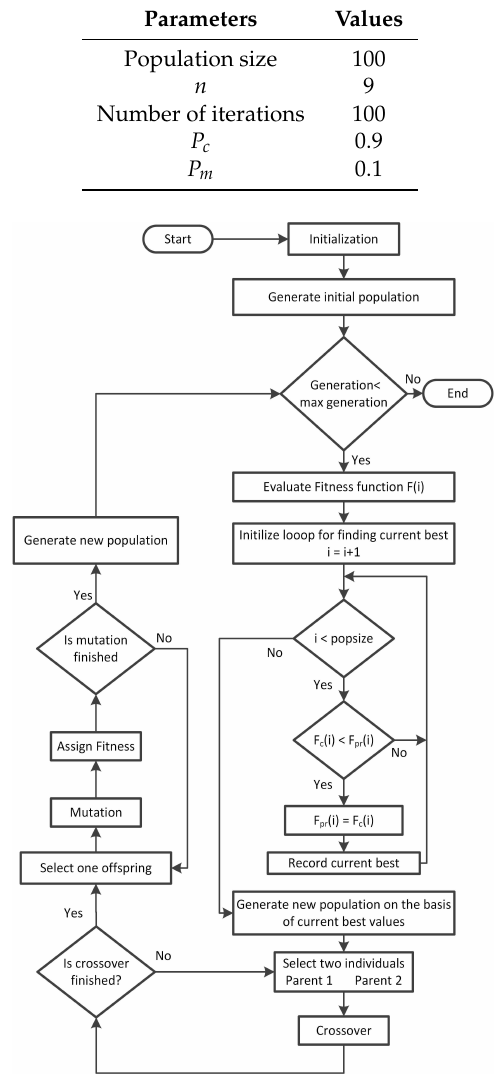
Figure 5. Flow chart of